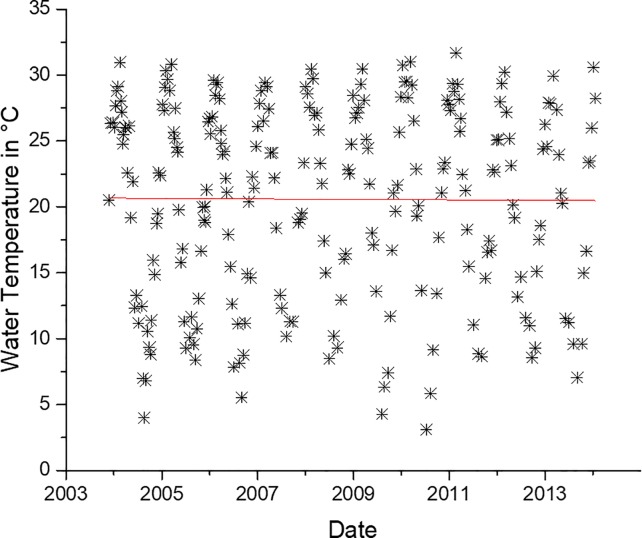
Water temperature at station 70S in the Neuse River Estuary during each sampling date.Slope of regression line is not significantly different than zero (p>0.05).